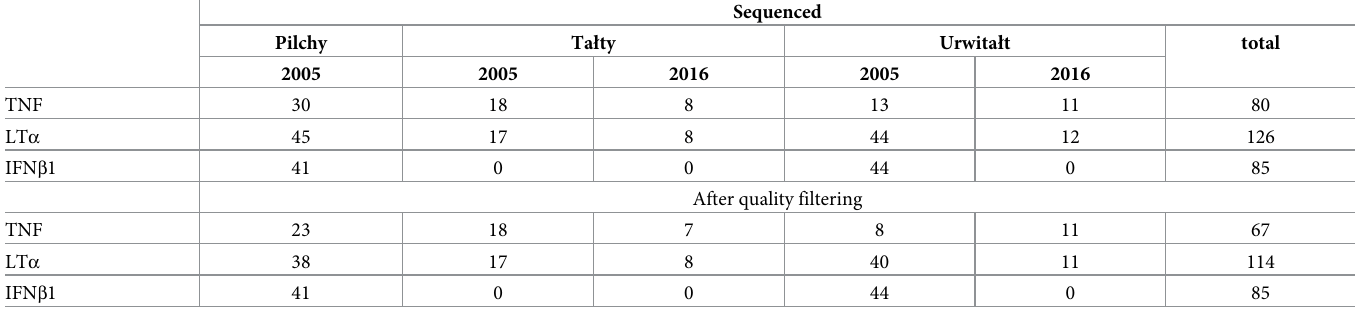
Table 1. Number of samples analysed per gene, site and year. As explained in the Methods, only samples with all SNP successfully genotyped were included in the asso- ciation analysis, these are presented in the bottom part of the table. For technical reasons, not all individuals were genotyped in all